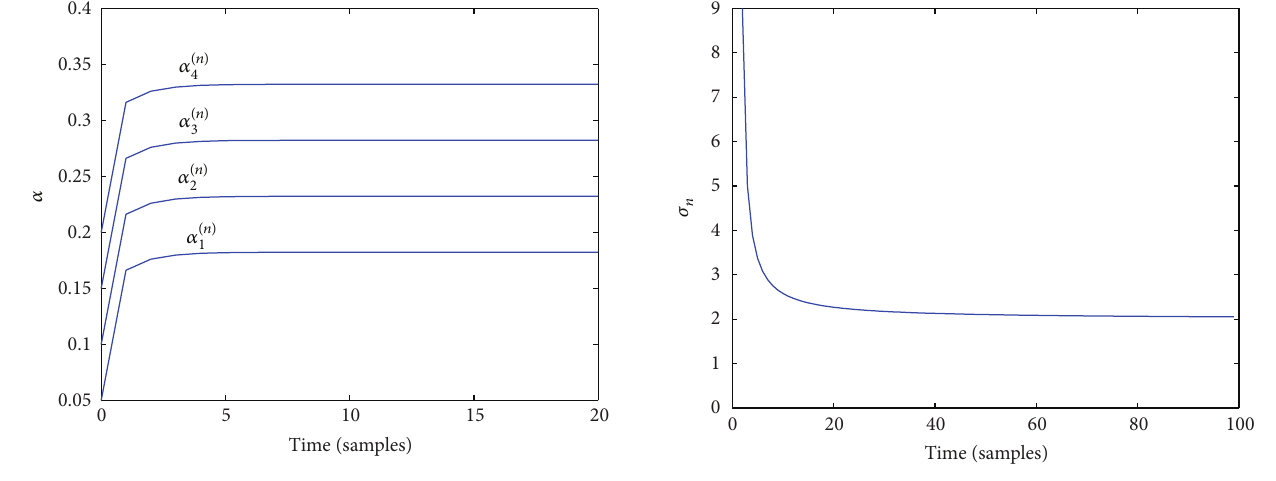
Figure 8: Evolution of 𝜎 𝑛 with time.